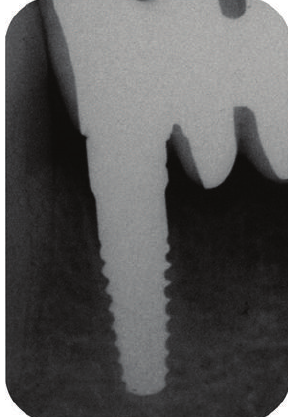
Figure 10: X-ray image of the zirconia implant placed in area 4.2, six months after surgery.